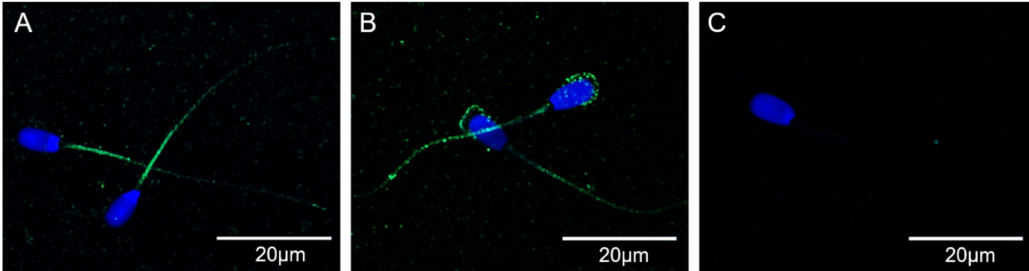
Figure 3. Representative confocal microscopy images of the expression and localization of CXCR4 in spermatozoa. From left to right, CXCR4 in uncapacitated ( A ) and in vitro-capacitated ( B ) spermatozoa, as well as the blocking peptide control, solely showing sperm nuclei ( C ), Blue: nuclei (Hoechst 33342); Green: